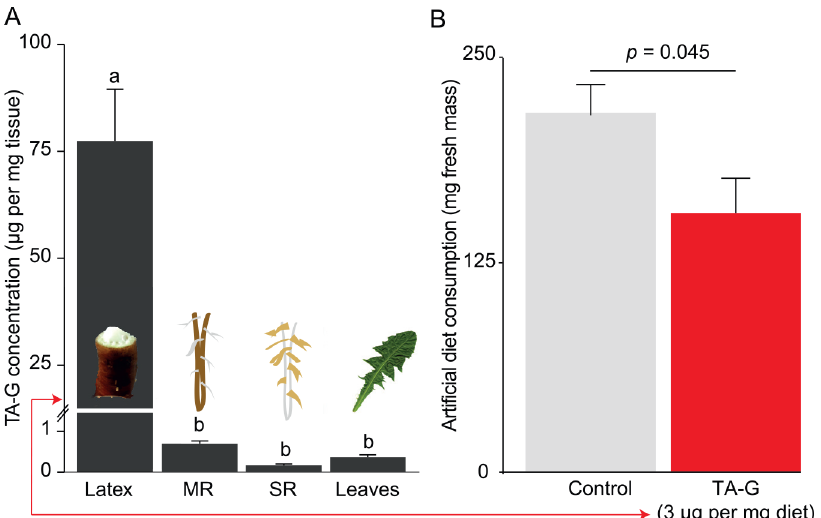
Fig 4. TA-G reduces larval feeding on artificial diet at ecologically relevant concentrations. A. TA-G concentration across tissues. B. M . melolontha consumed 40% less TA-G-containing diet compared to control diet in a nonchoice experiment after 24 h (Student ’ s t test, n = 15). Underlying data can be found in S1